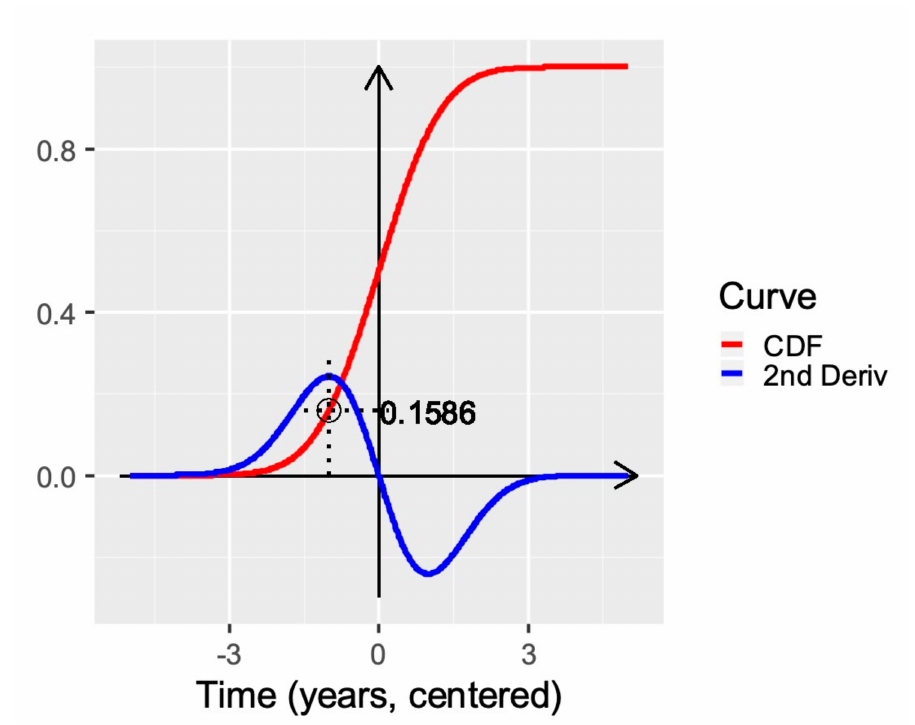
Figure A4. Cumulative distribution function (red) of the normal distribution and its 2nd derivative (blue). The location of the maximum of the 2nd derivative and the corresponding ordinate is indicated with a dashed